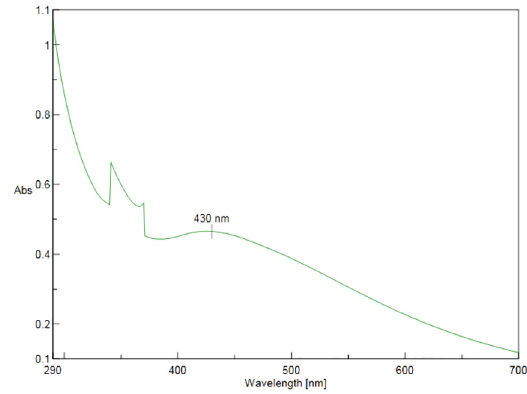
Figure 1. UV – Visible spectra of Aqueous extract of Imperata cylindrica with 1 mM Silver